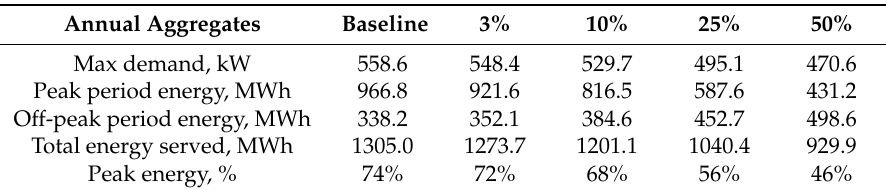
Table 9. Aggregate energy results by scenario.